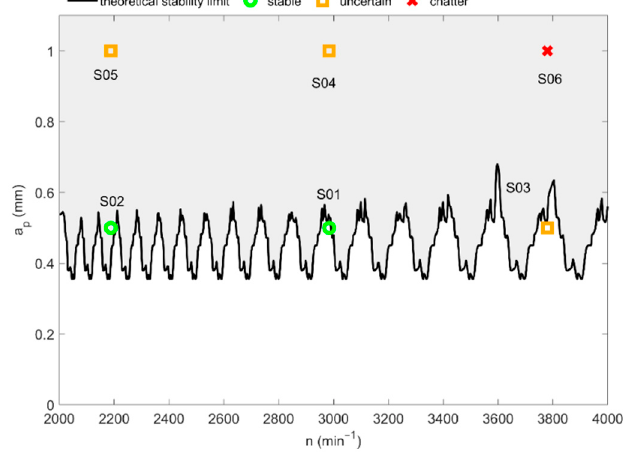
Figure 4. Workpiece FRF at directions X and Y for before and after machining tests.